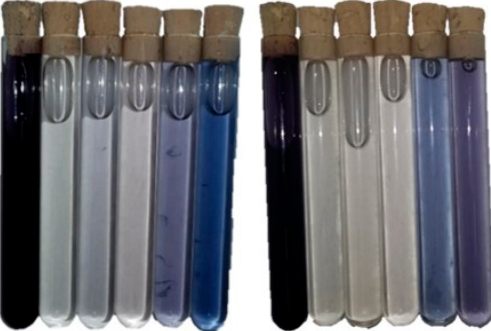
Figure 13. Dye removal process using APTES L1 (left group) and APTES L2 (right group) adsorbents. From left to right in each group: (A) Original Dye preparation, (B) water treated from cycle 1, (C) water treated from cycle 2, (D) water treated from cycle 3, (E) water treated from cycle 4 and (F) water treated from cycle 5.